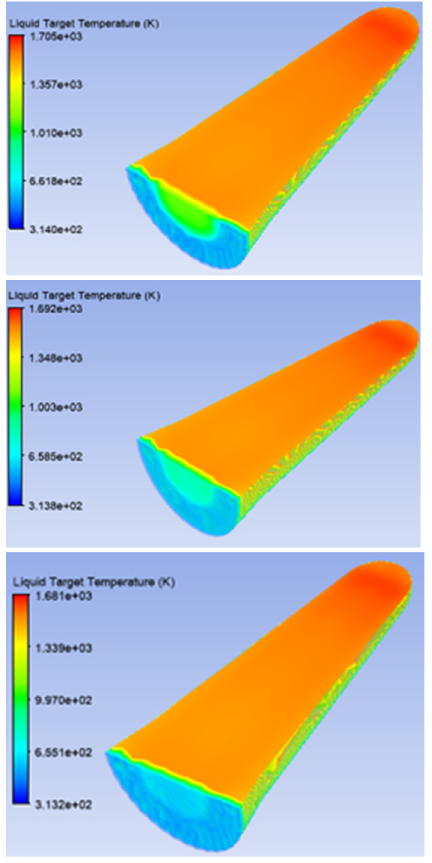
Figure 9. Temperature of the liquid target for helium mass flow rates of 0.1, 0.3, 1, 3 and 8 L/s (from top to bottom ).